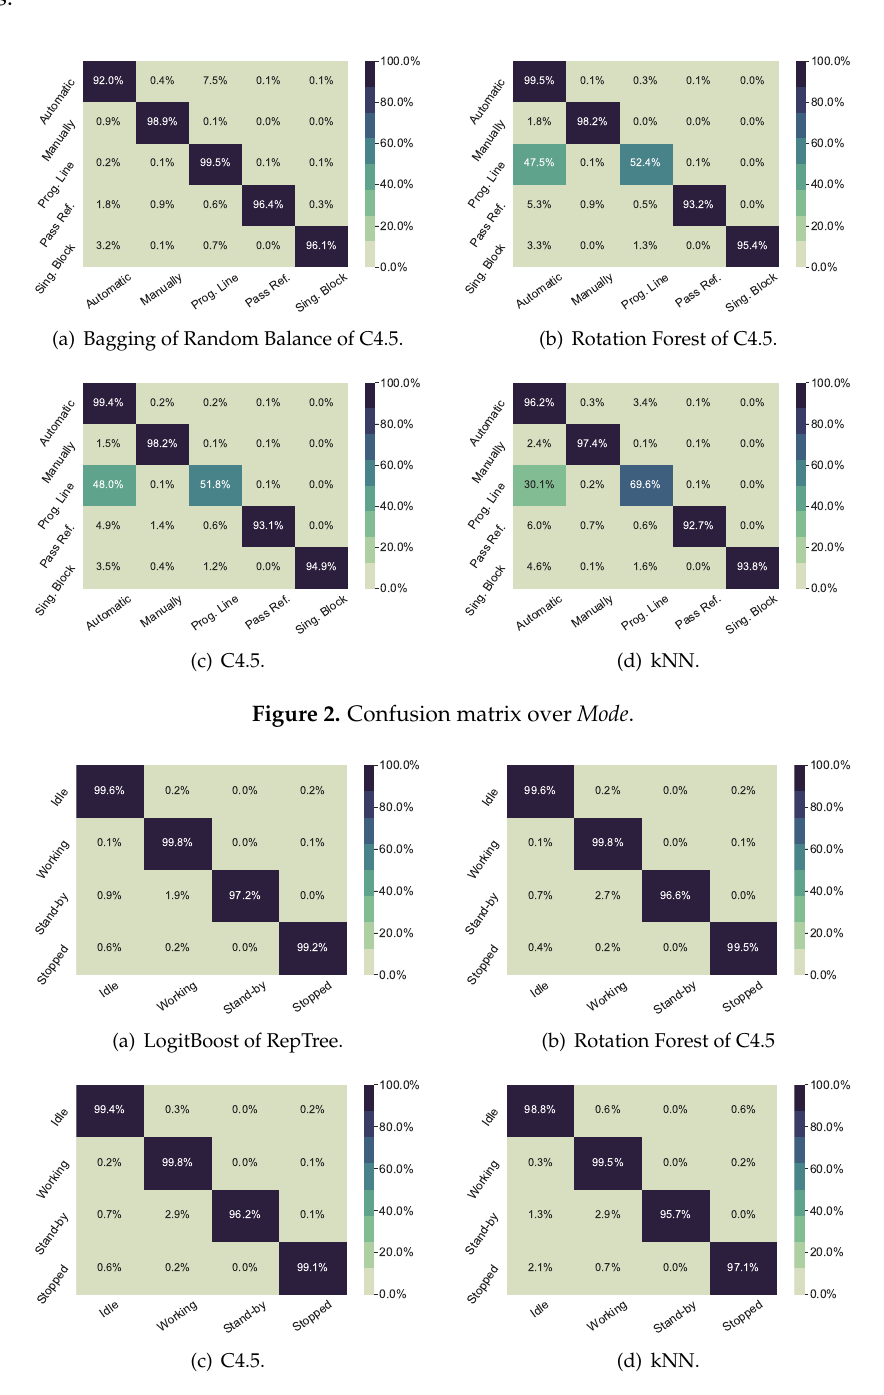
Figure 3. Confusion matrix over State